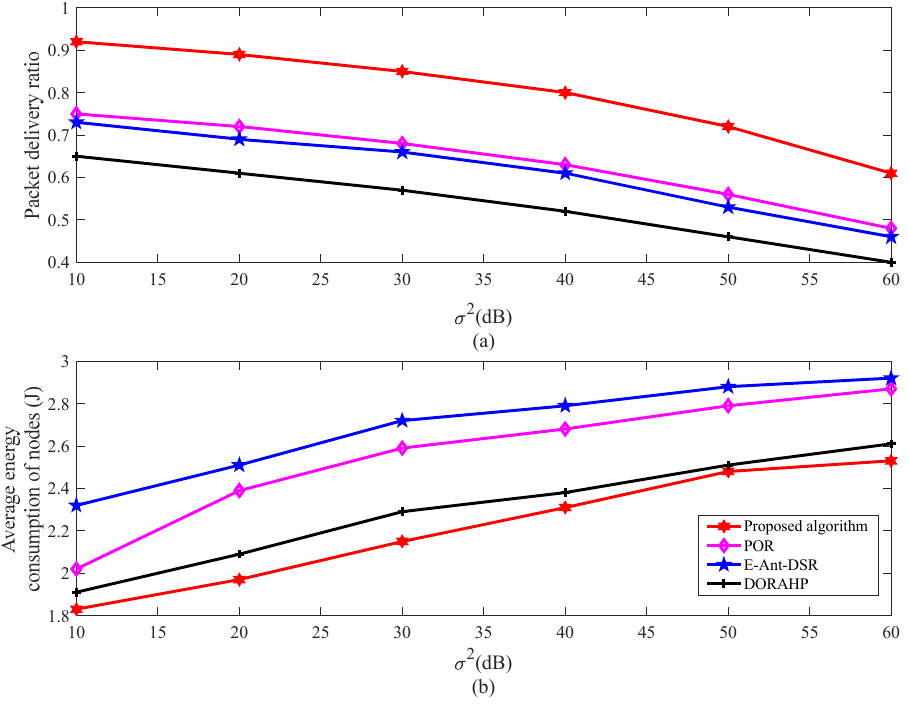
2 σ . ( a ) Packet delivery ratio. ( b ) Average energy consump-